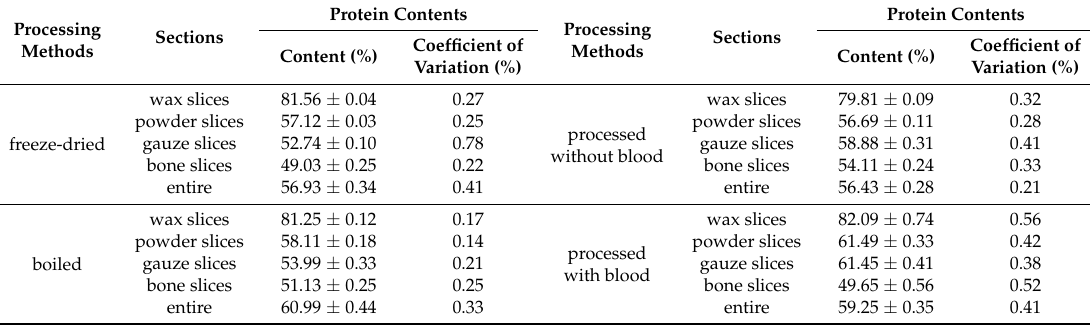
Table 4. Protein contents in different sections of antler velvet with different processing methods which were determined by combustion method.